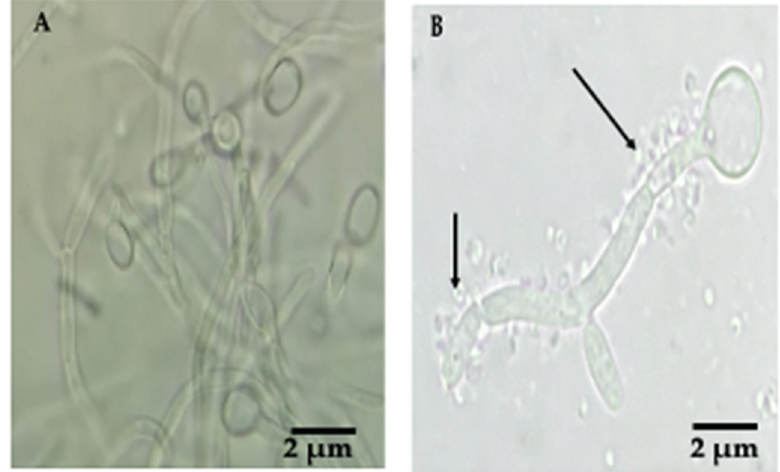
Figure 4. ( A ) Wet mount of a pure culture of C. albicans VT ‐ 3 cells, no extracellular bacteria nor bacteria adhered to the surface of hyphae can be seen; ( B ) wet mount of a co ‐ culture of H. pylori G ‐ bacteria adhered to the surface of hyphae can be seen; ( B ) wet mount of a co-culture of H. pylori G-27 27 strain and C. albicans VT ‐ 3 strain incubated under an anaerobic condition showing extracellular strain and C. albicans VT-3 strain incubated under an anaerobic condition showing extracellular H. H. pylori bacteria adhered to the filamentous yeast structures (black arrow). pylori bacteria adhered to the filamentous yeast structures (black arrow).